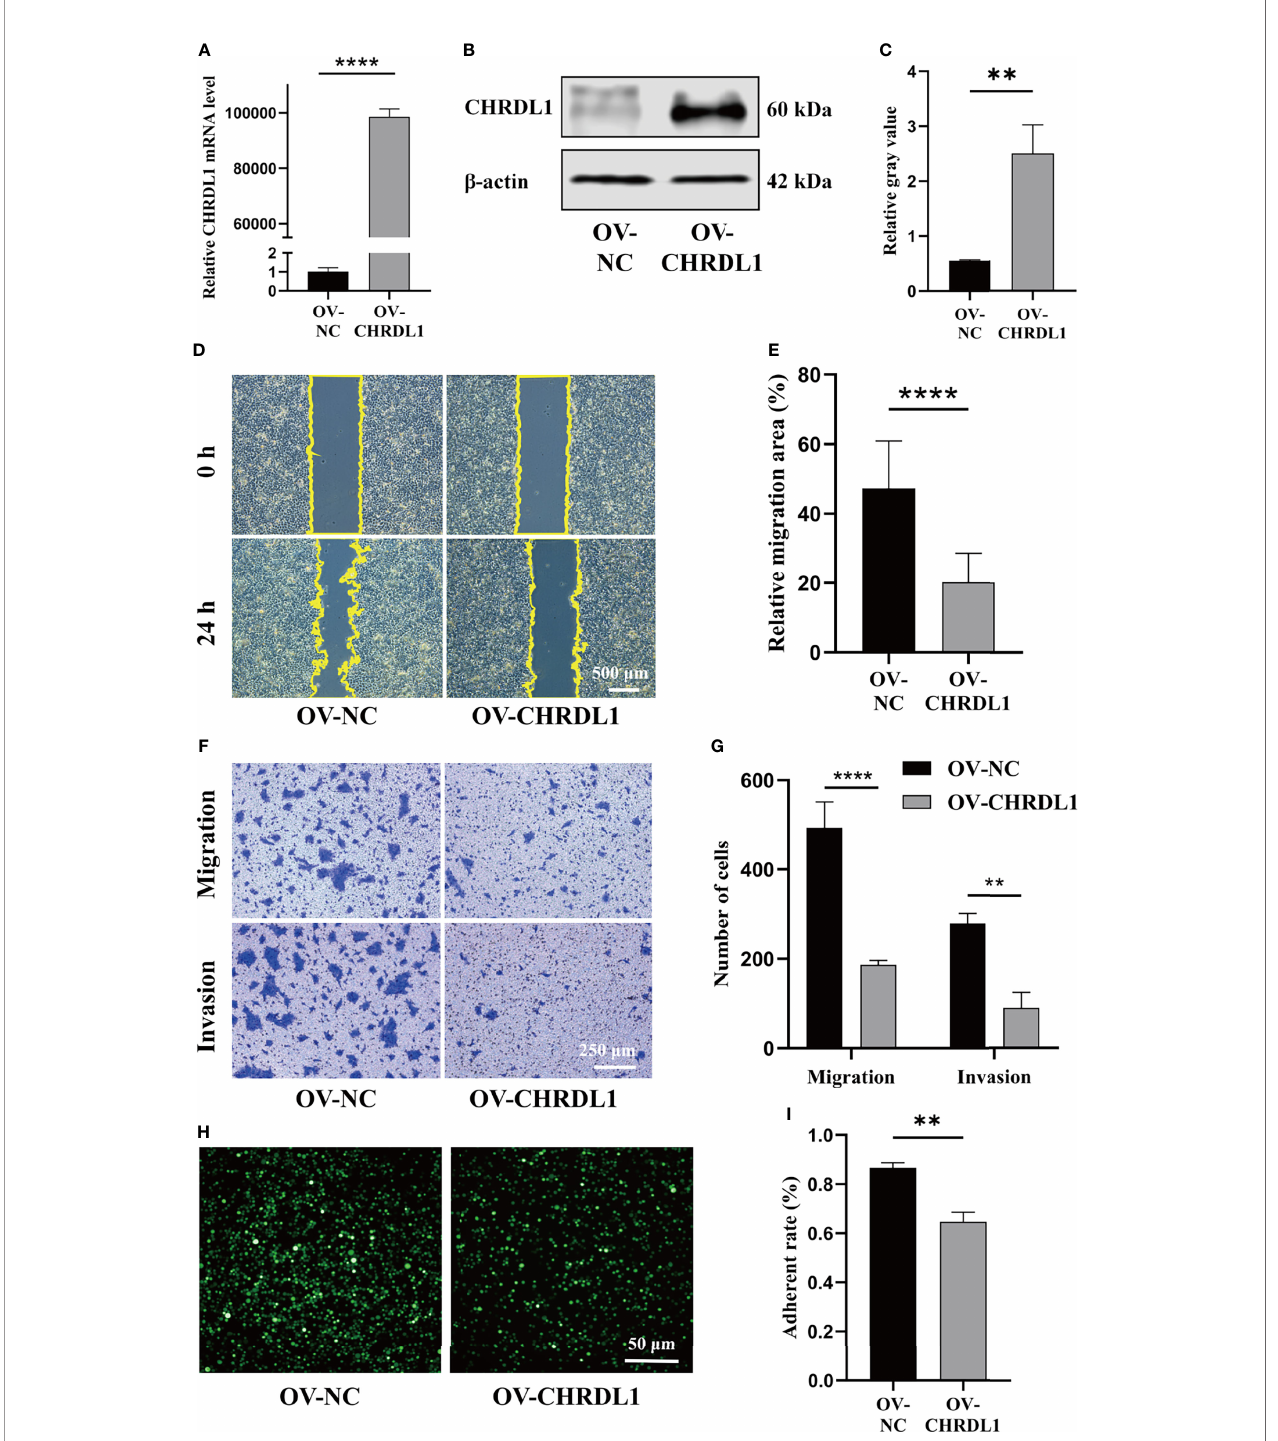
FIGURE 2 | Overexpression of CHRDL1 inhibits CAL27 cell migration, invasion, and adhesion. (A) Relative mRNA expression of CHRDL1 in CAL27 cells after lentivirus transfection. (B, C) CHRDL1 protein expression in CAL27 cells after lentivirus transfection was identi fi ed by Western blot and quantitatively analyzed. (D, E) Representative images of wound-healing assays of transfected CAL27 cells at 0 and 24 h and statistical results from each group. (F, G) Migration and invasion assays of transfected CAL27 cells. Representative images of cell migration and invasion in each group are shown in (F) . Statistical analyses of cell migration and invasion are shown in (G) . (H, I) Cell adhesion assay of transfected CAL27 cells. Representative fl uorescence images from each group (H) and statistical analyses of the adherence rate (I) . Error bars represent the standard deviation. ** p < 0.01, *** p <